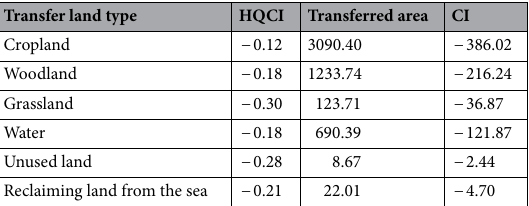
Table 5. Impact on habitat quality of land types transferred to construction